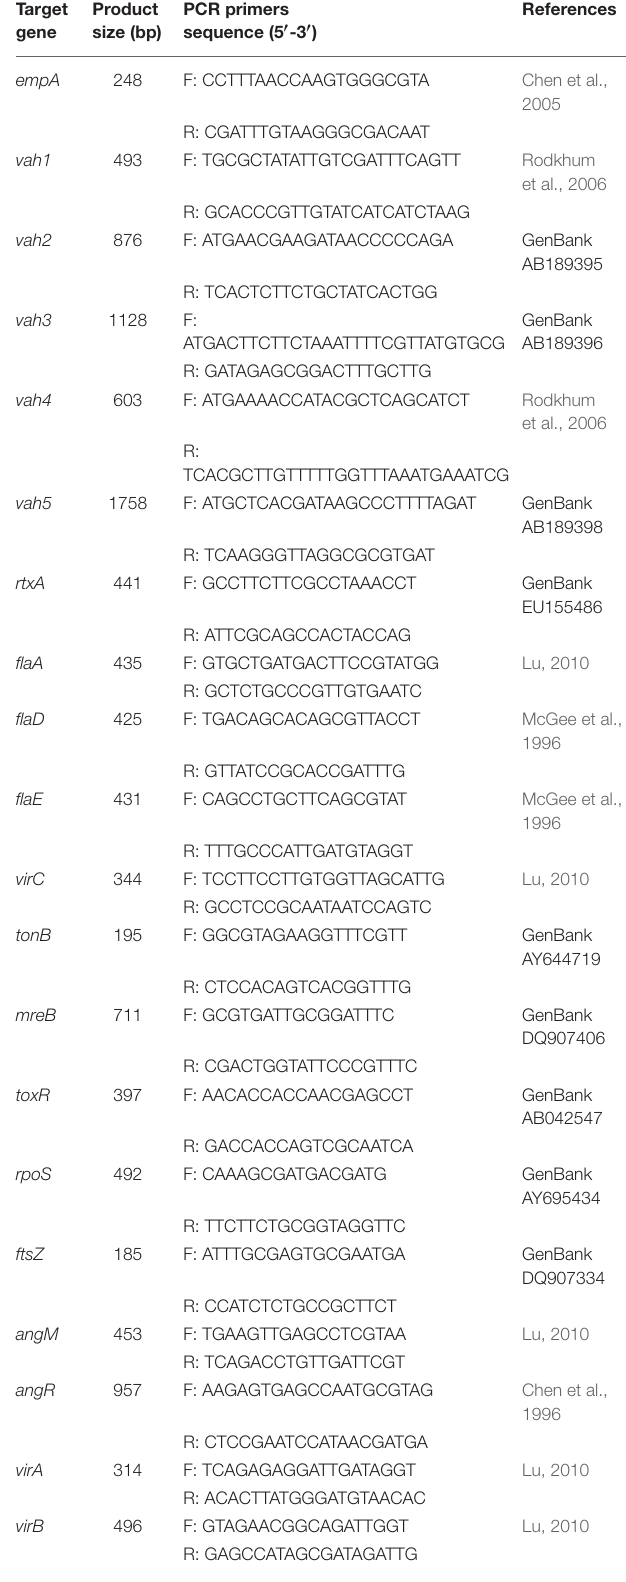
TABLE 1 | Sequence of primers used for detection of virulence genes. Target